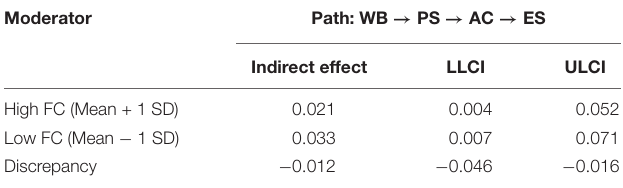
TABLE 4 | Moderated chain mediation effect